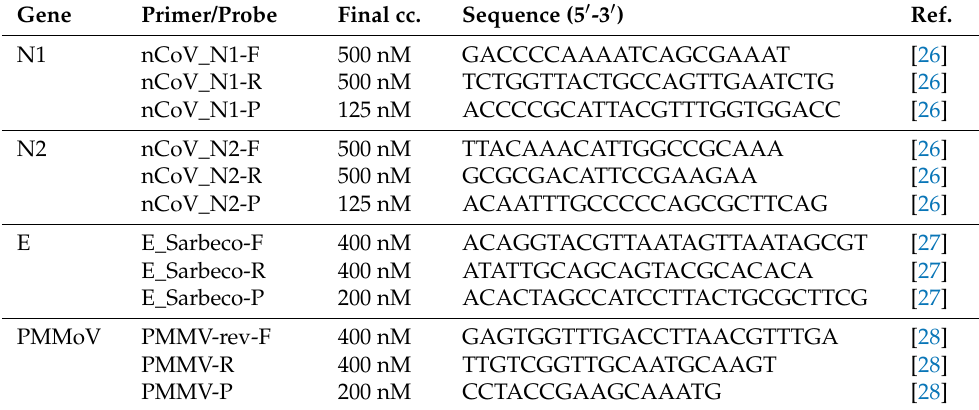
Table 1. Overview of primers/probes sequences used for the RT-qPCR assays. Gene Primer/Probe Final